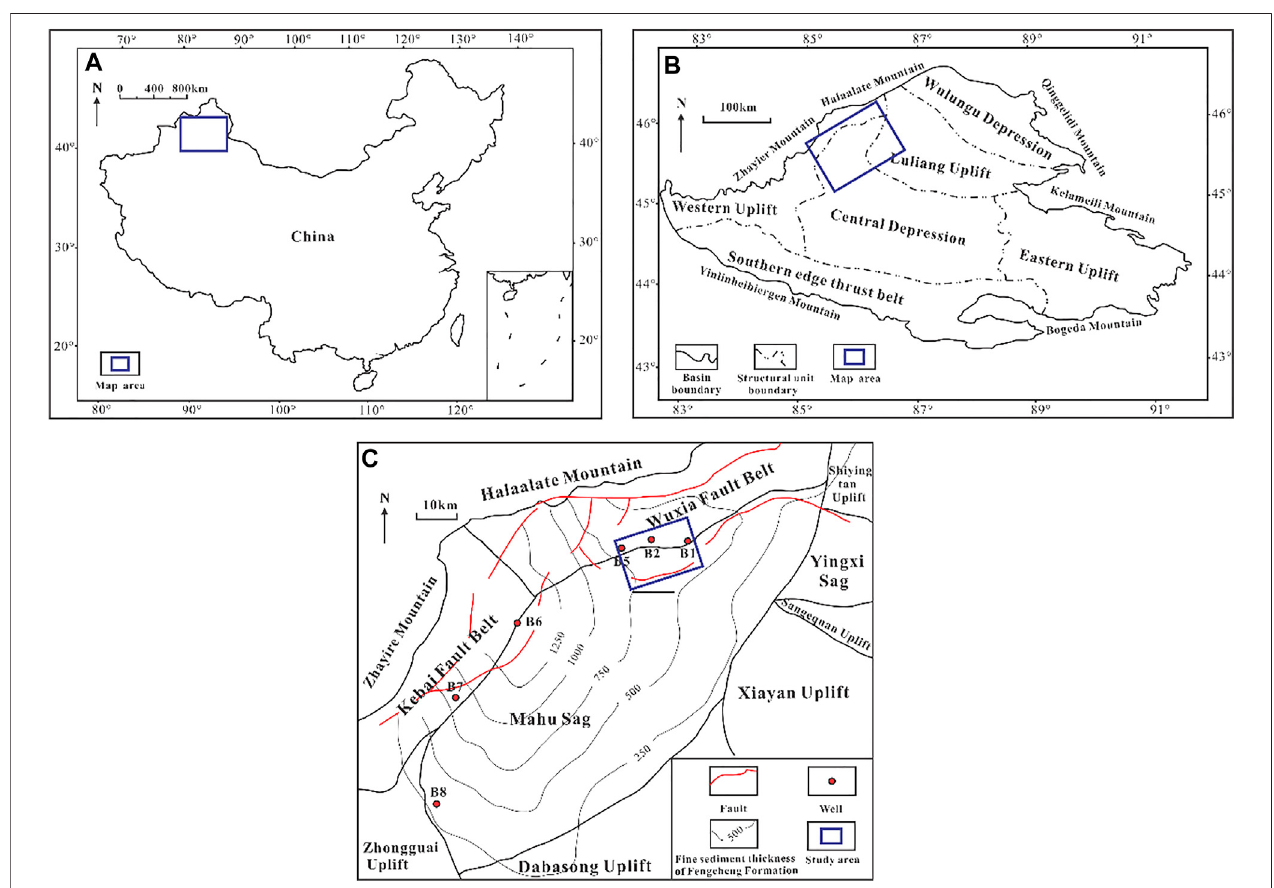
FIGURE 1 | Tectonic division of the Mahu Sag of the Junggar Basin (Zhi et al., 2021b; Wang et al., 2021). (A) Location of Junggar Basin. (B) Location of the Mahu Sag and Structural Unit of Junggar Basin. (C) Location of the study area and the structural unit of the Mahu Sag.